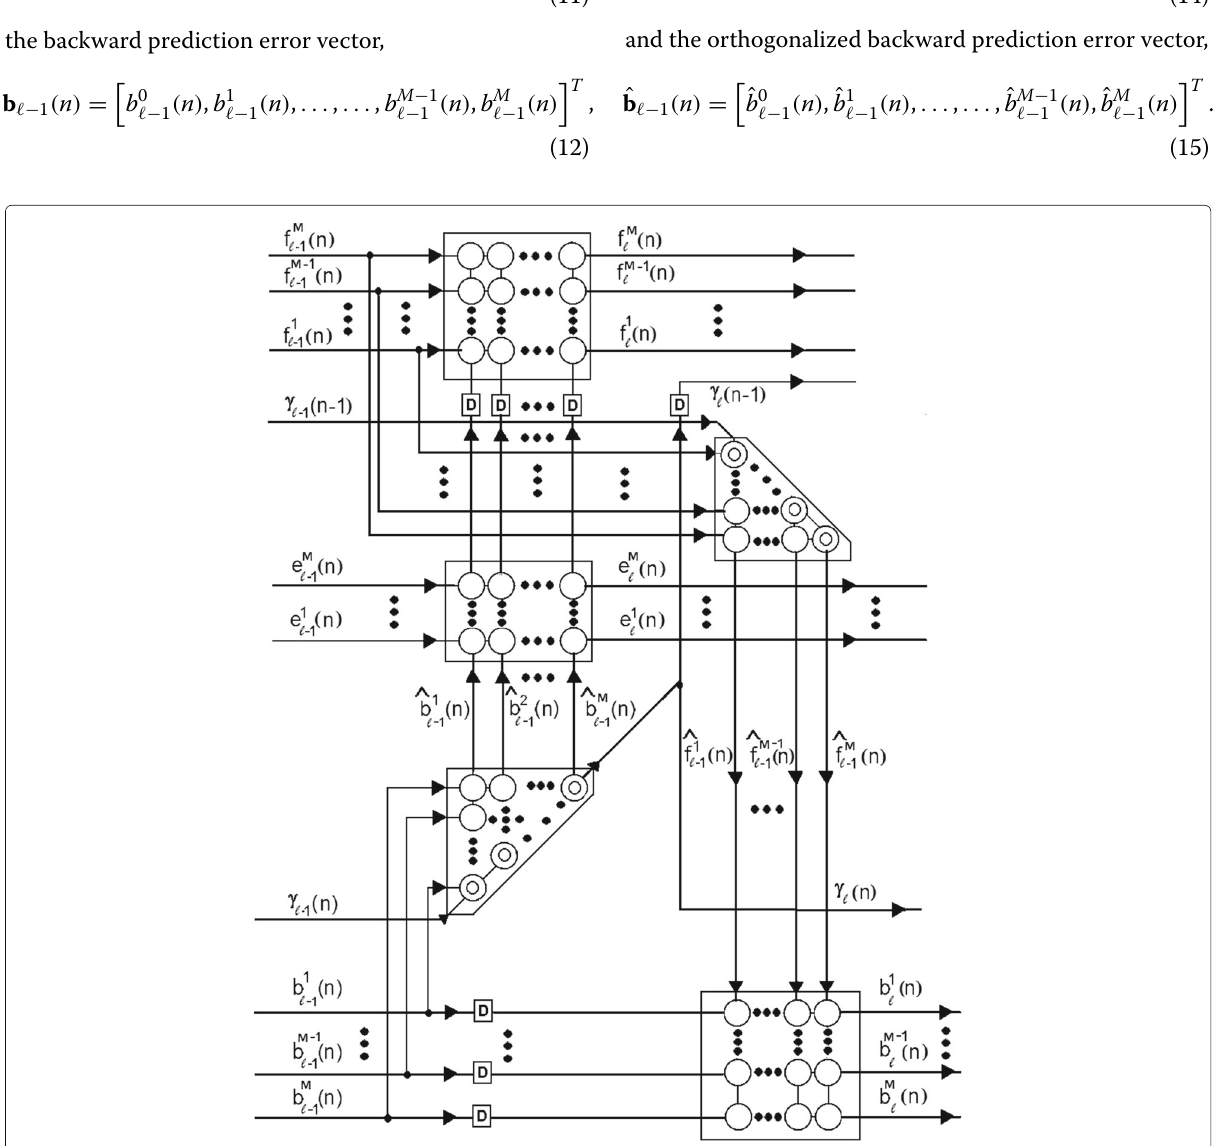
Fig. 2 A diagram of the original